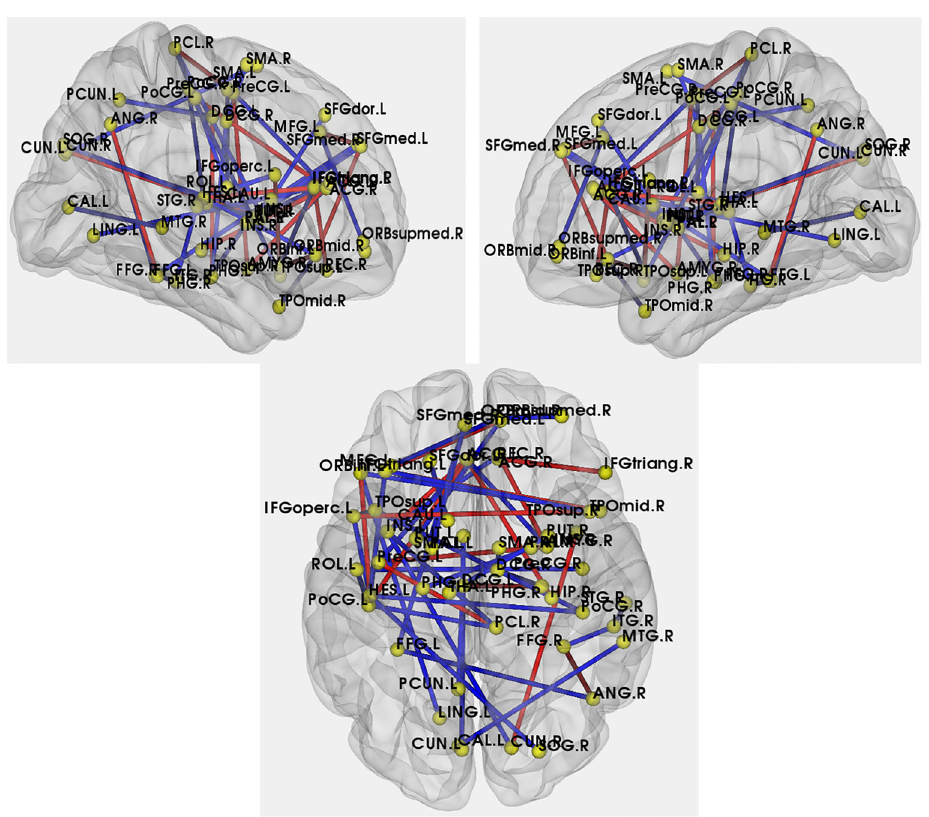
Fig 8. Abnormal interregional correlations in APOE ε 4 carriers compared with APOE ε 4 noncarriers. The yellow dots indicate the AAL brain regions which showed the significantly abnormal correlations. The red and blue lines indicate the significantly increased and decreased interregional